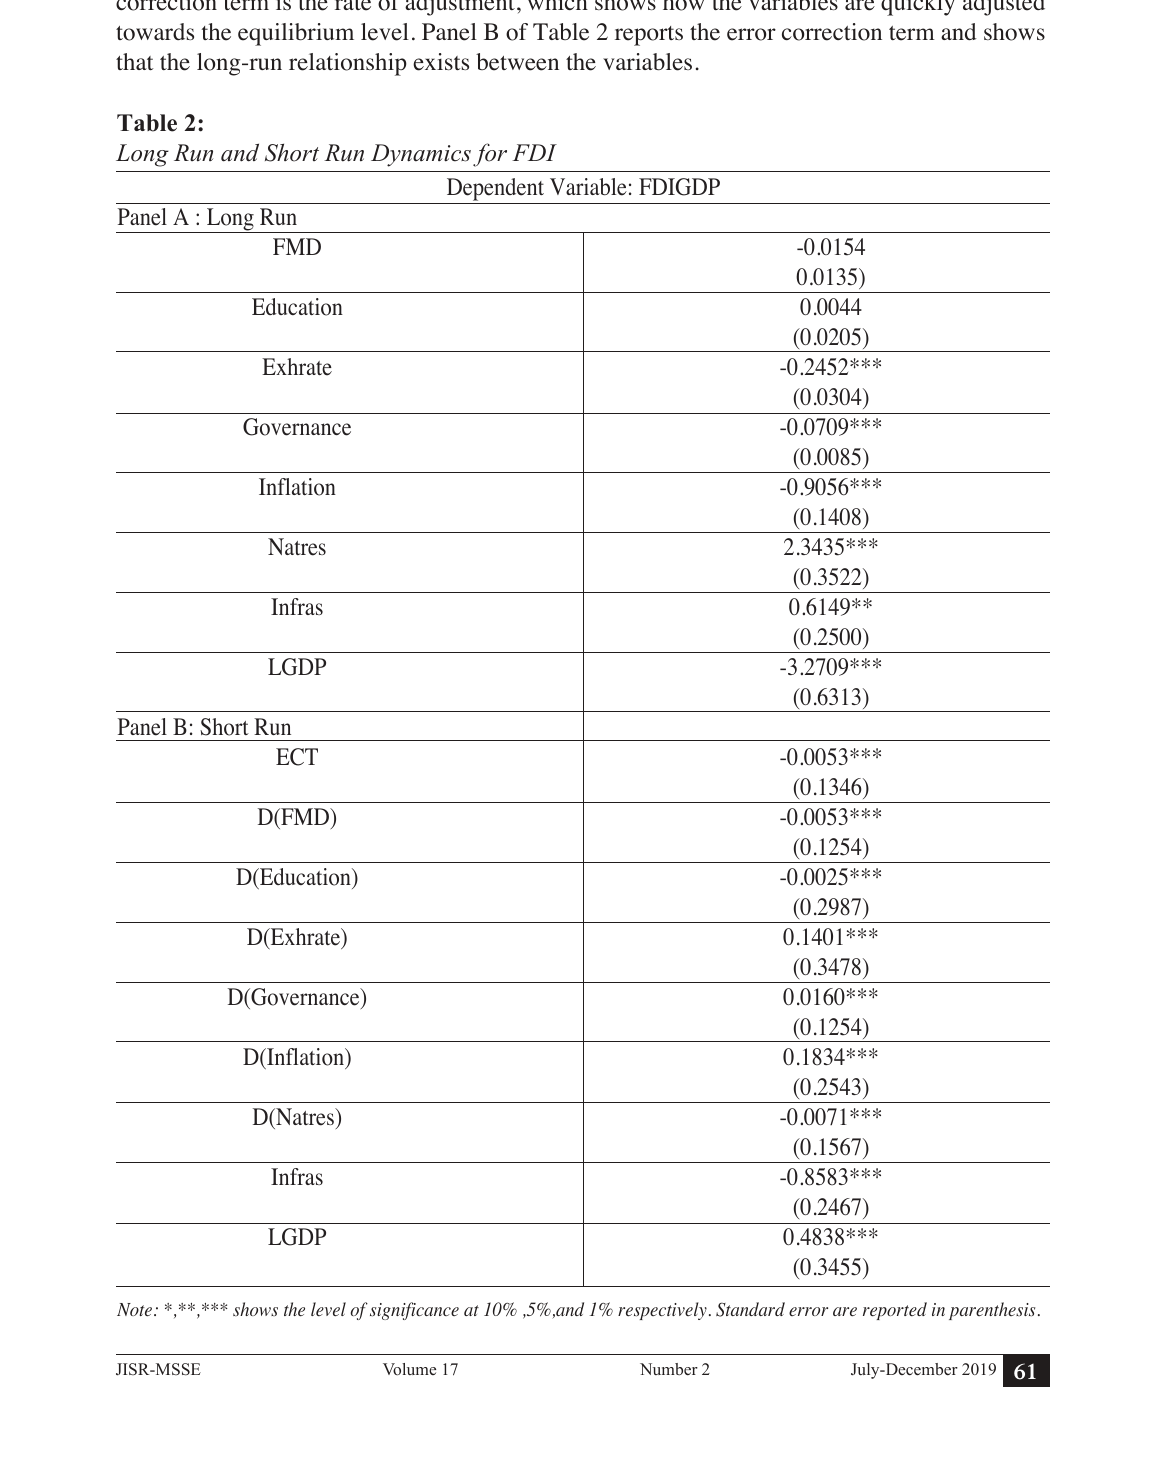
Table 2: Long Run and Short Run Dynamics for FDI Panel A : Long